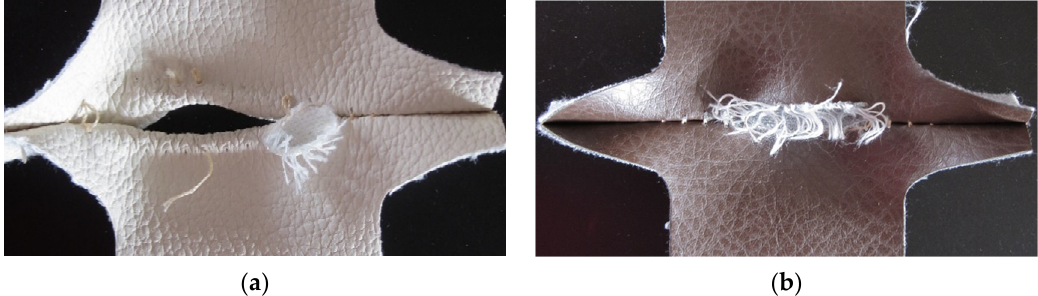
Figure 4. Seam slippage ( a ) PU faux leather fabric; ( b ) PVC faux leather fabric.